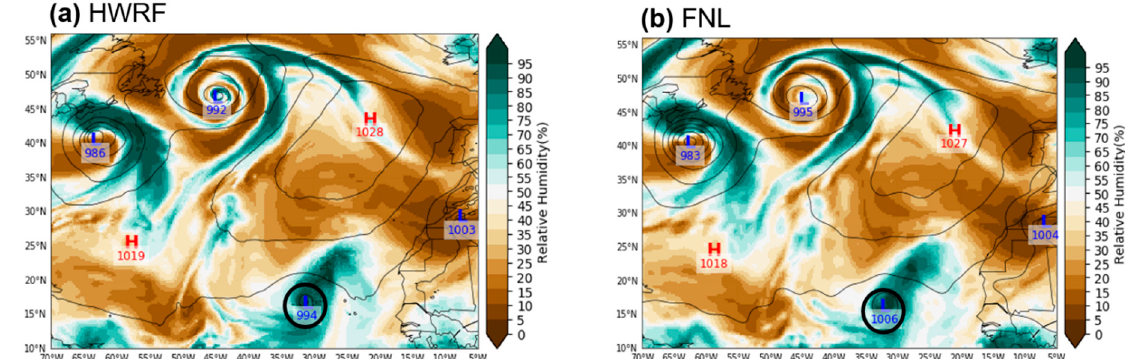
Figure 5. Mid-tropospheric (400–700 hPa average) relative humidity (RH, shaded) and mean sea level pressure (MSLP, contours and centers) in the environment near Hurricane Irma from ( a ) 12 h into an HWRF forecast initialized at 1200 UTC on 30 August 2017 and ( b ) FNL valid at 0000 UTC on 31 August 2017. The center position of Irma is identified by a black circle. RH is measured as a percentage, and MSLP has units of hPa.